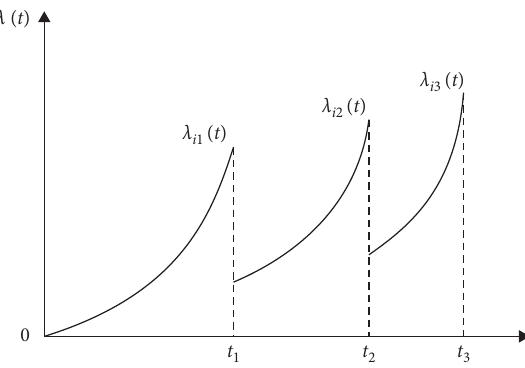
Figure 2: Failure rate change of imperfect